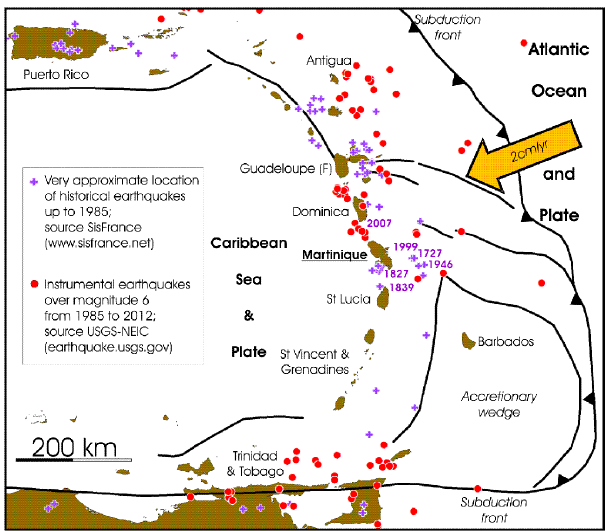
Fig. 1. Sketch map of Martinique Island within the Caribbean- Atlantic plate-boundary setting. The main regional faults and earth- quakes are illustrated. The large arrow represents the motion of the Atlantic plate relative to the Caribbean plate (from Lopez et al., 2006).